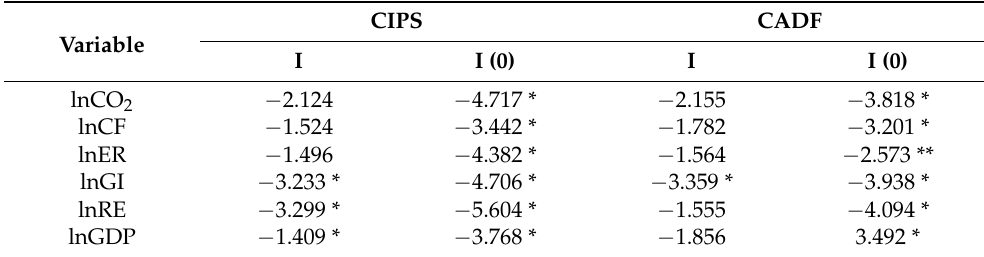
Table 6. Panel unit root test.